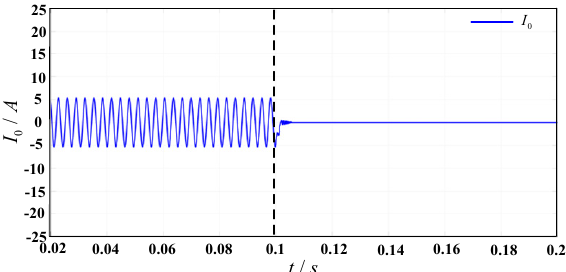
Figure 23. Simulation waveform of the current in the midline before and after reshaping.